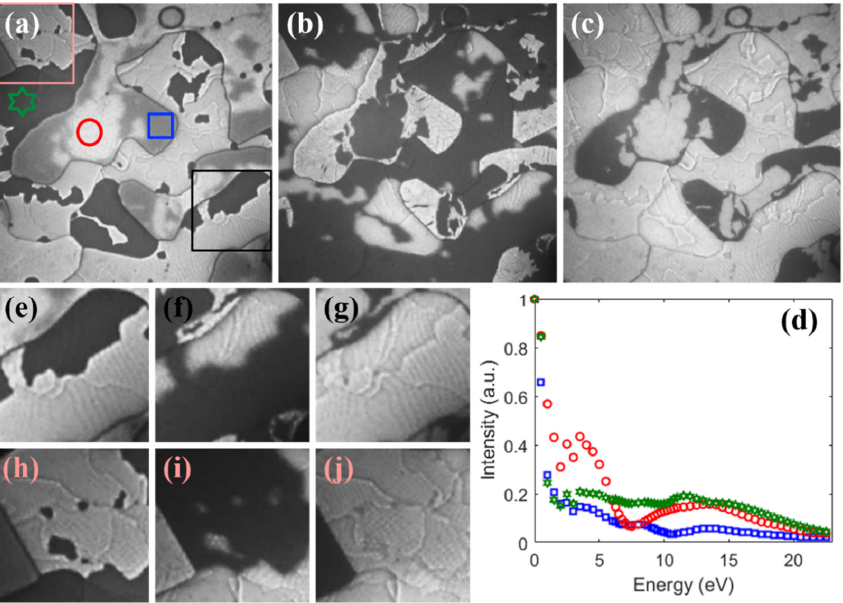
Figure 5. LEEM images of silicene annealed to 530 K and recorded at RT. Small squares in ( a ) denote regions where reflectivity curves ( d ) were measured. Large squares in ( a ) are magnified in ( e – j ). Im- ages registered at: E = 3.7 eV ( a ), E = 6.7 eV ( b ), E = 9.9 eV ( c ), ( a – c ) 3.5 × 3.5 µ m 2 , ( e – j ) 1 × 1 µ m 2 .Color code and symbols of reflectivity curves ( d ) corresponds to color code and symbols of ROI in ( a